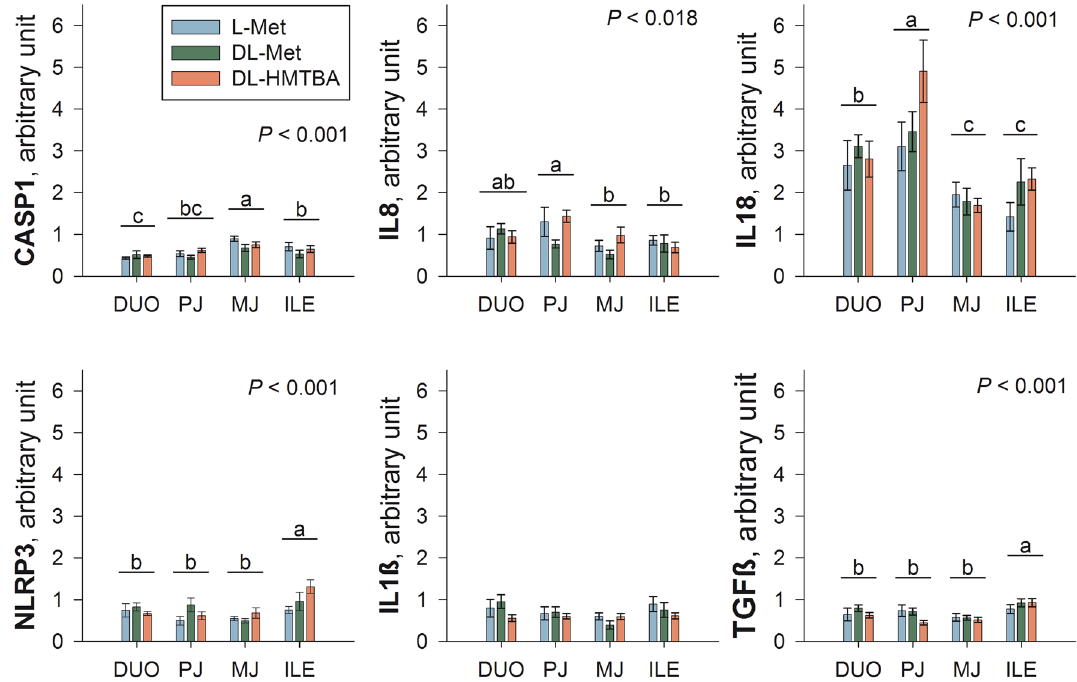
Figure 8. Calibrated normalized relative quantity expression of inflammation-related genes in duodenum (DUO), proximal jejunum (PJ), middle jejunum (MJ) and ileum (ILE) in DL-Met, L-Met and DL-HMTBA- fed pigs. Results are given as means with standard error. Significant differences between experimental groups are indicated by different letters a-c. P -Values of two-way ANOVA region main effects are given in each graph. There were no dietary treatment effects nor region × treatment interactions ( P >